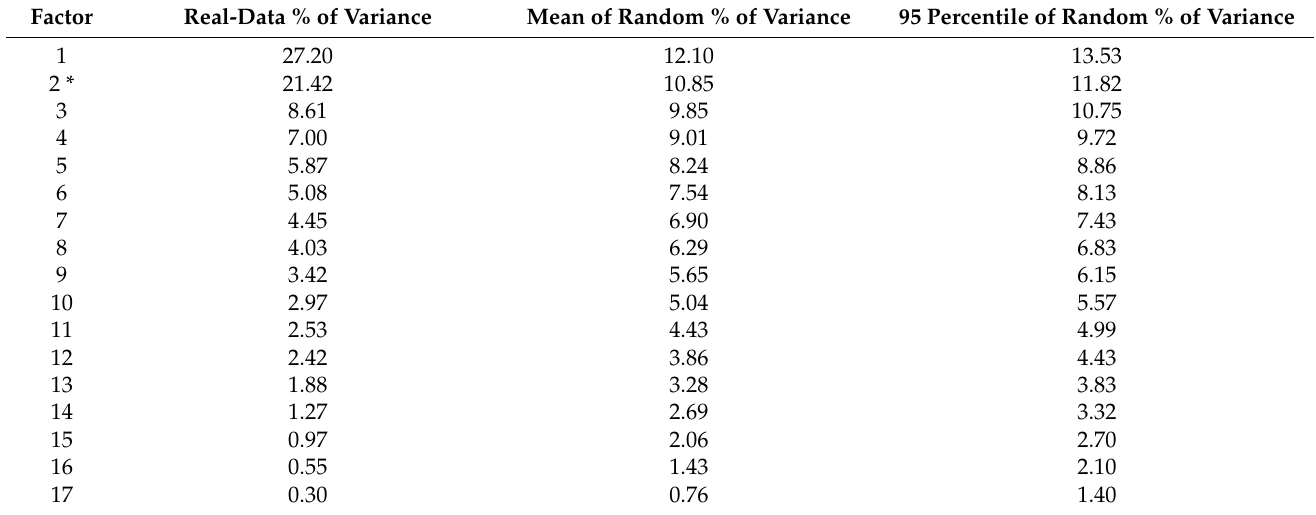
Table 1. Parallel analysis—minimum rank factor analysis (MRFA)